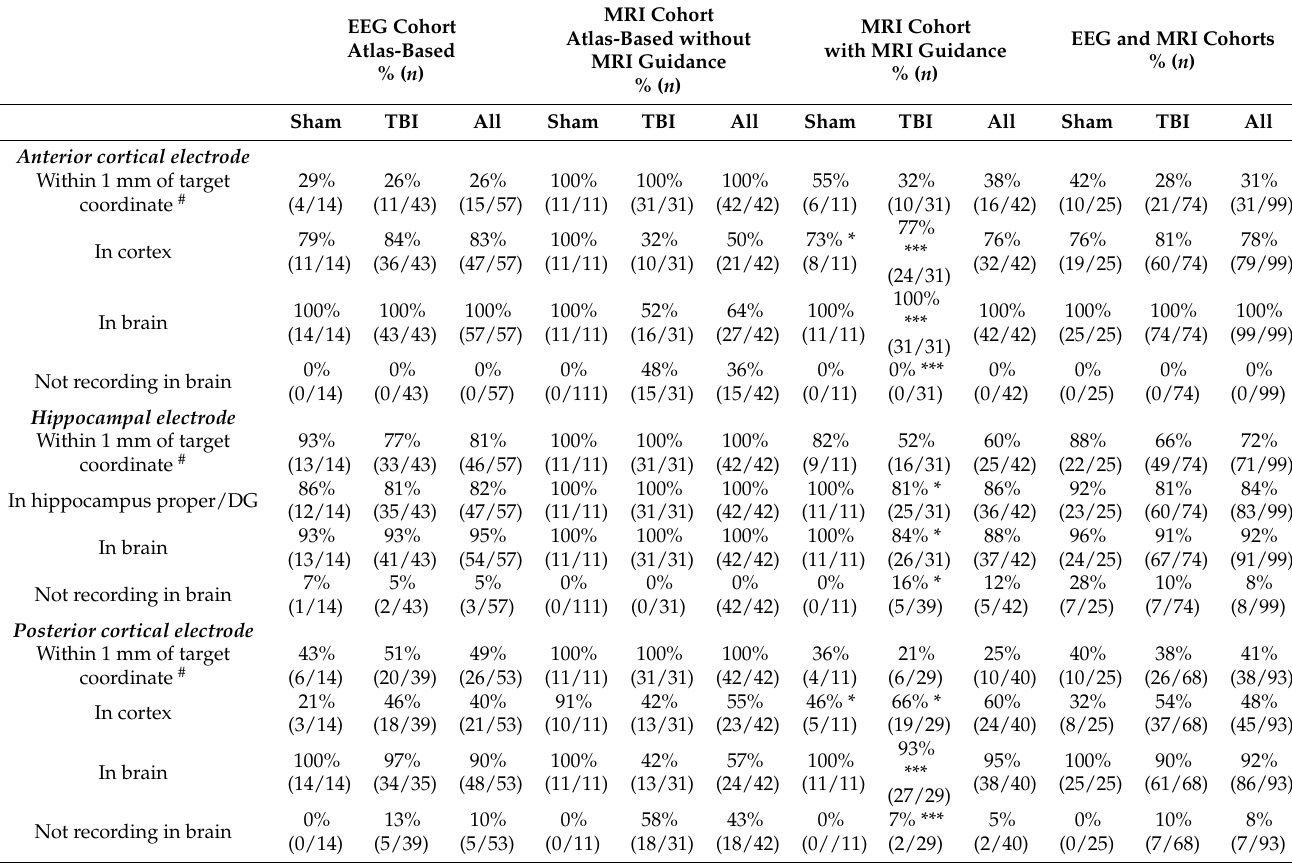
MRI Cohort with MRI Guidance